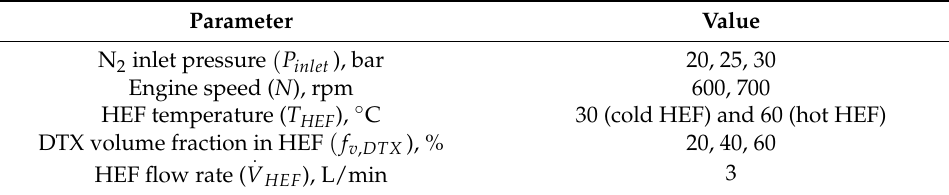
Table 4. Engine operation and HEF flow conditions.